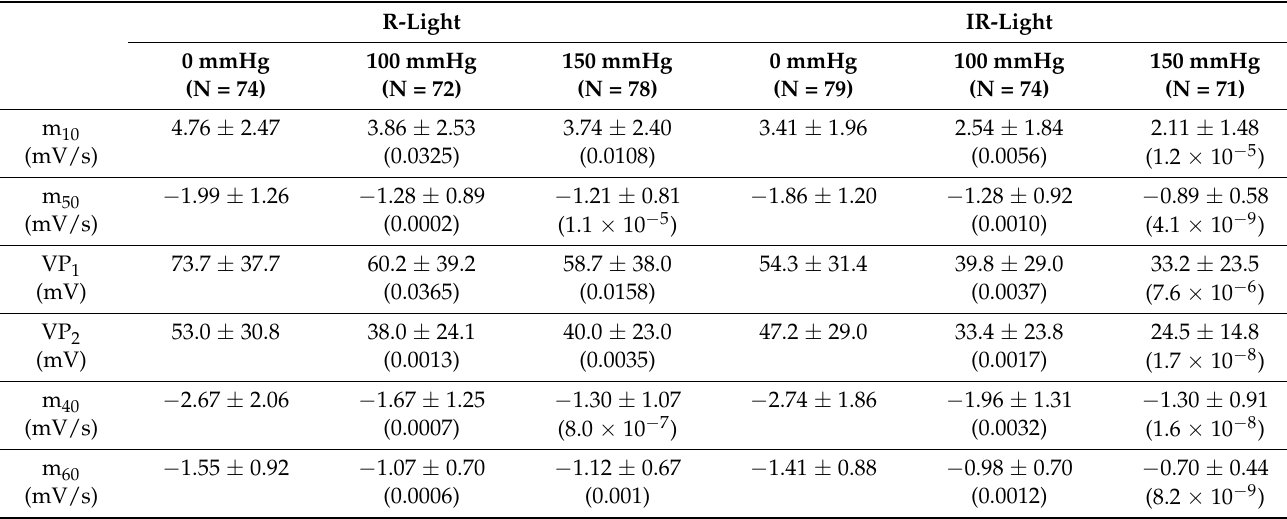
Table 2. Statistical analyses of six parameters between the negative group (0 mmHg) and positive groups (100 mmHg and 150 mmHg) by t -test. A p -value of less than 0.05 is highlighted in red.